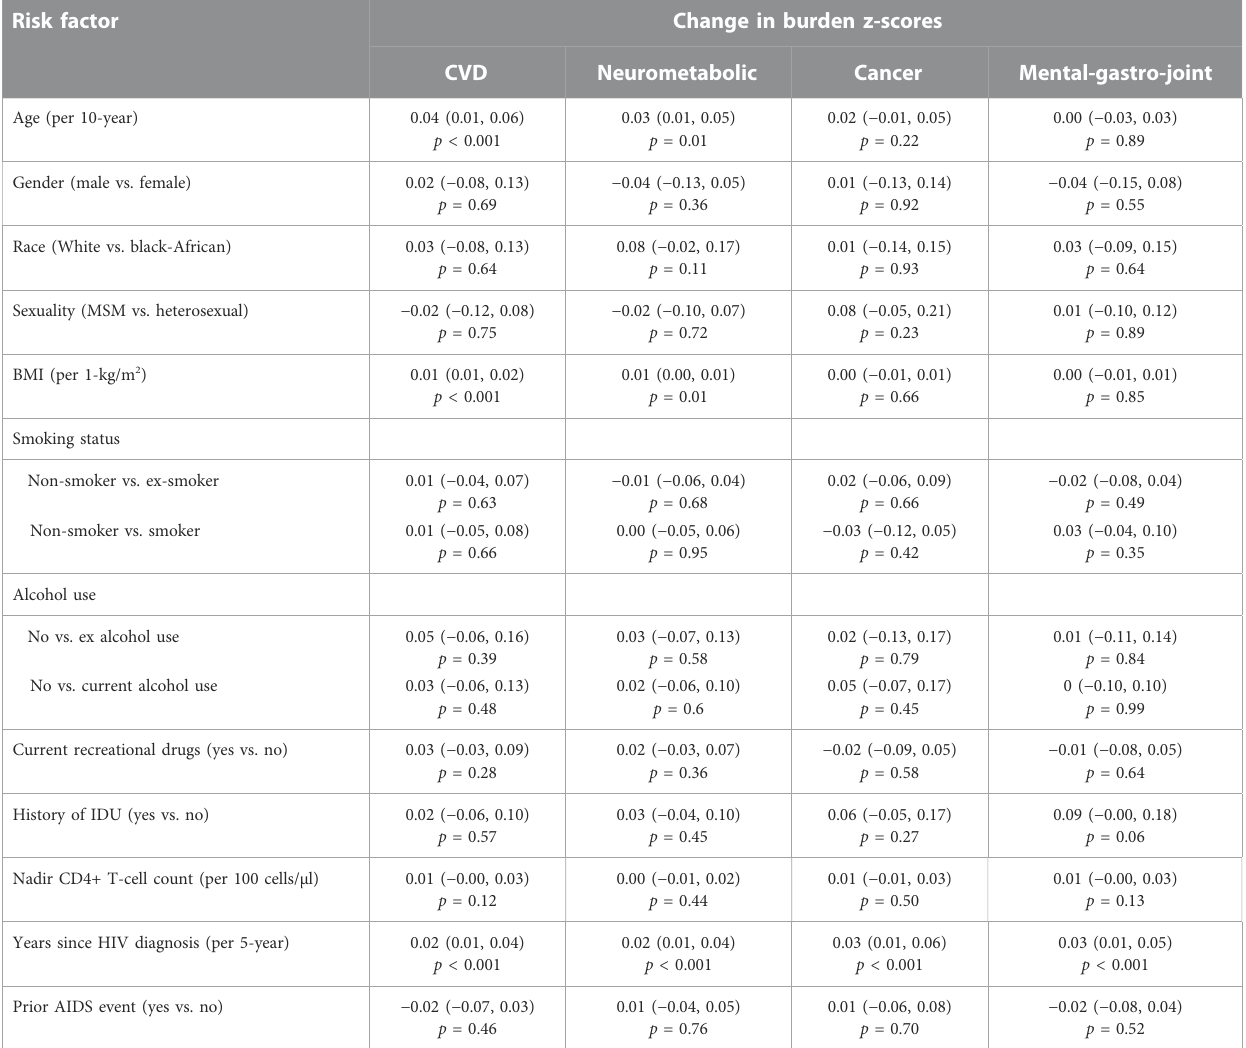
TABLE 4 The relative contributions of demographic, lifestyle and clinical factors to an increase in burden of multimorbidity patterns ( n = 788) assessed using multivariable linear regression models, with regression coef fi cients (95% con fi dence intervals) and associated p -value reported. Risk